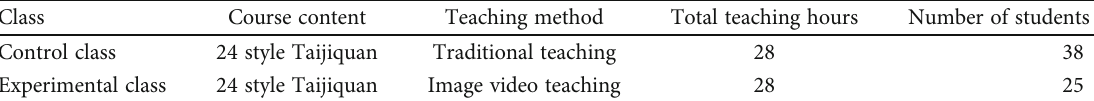
Table 1: Analysis of class completion of two classes.